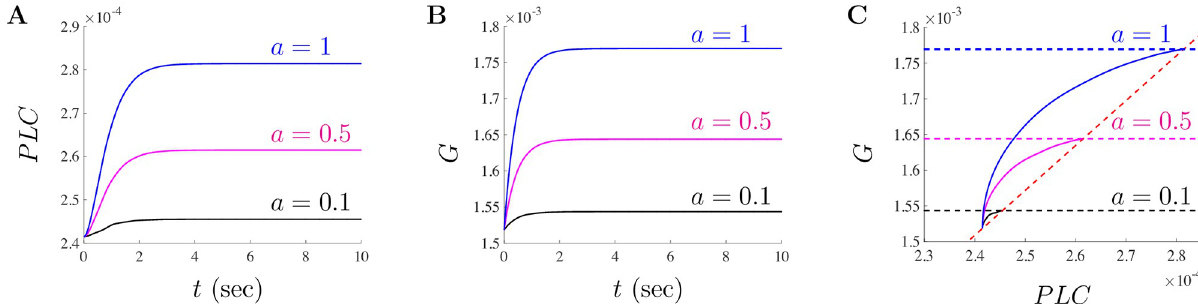
Fig 5. Steady-state values for PLC and G for doses of a � 1 μ g/ml of A β . The steady-state fraction of activated PLC and G-proteins settles to a new value when a = 0.1 (black), a = 0.5 (magenta), and a = 1 (blue) in A and B , respectively. Model solutions for the various small doses a -values are shown on the phase plane for PLC and G in C . The dashed lines correspond to the PLC nullcline (red) and the G nullclines (black, magenta, and blue).